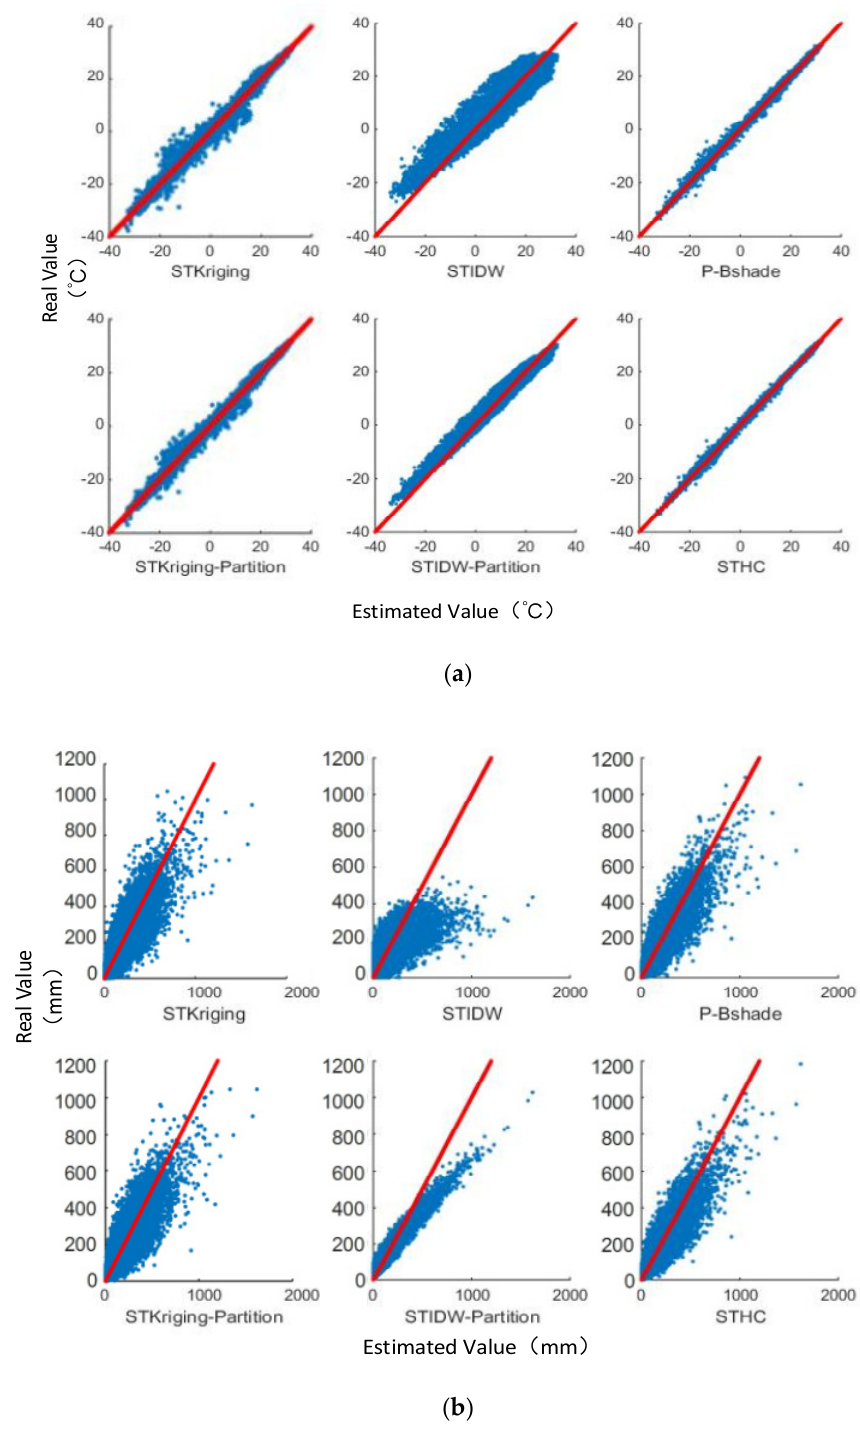
Figure 7. Scatterplot between observed value and the estimated value; ( a ) temperature and ( b ) precipitation datasets.